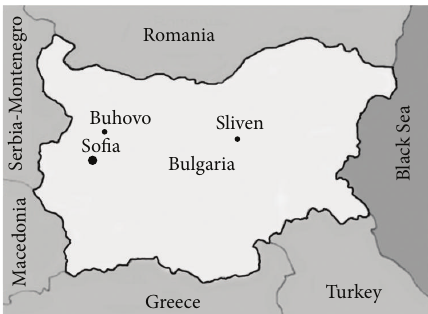
Figure 1: Map of Bulgaria and the location of the studied sites Buhovo (BuhC and BuhD) and Sliven